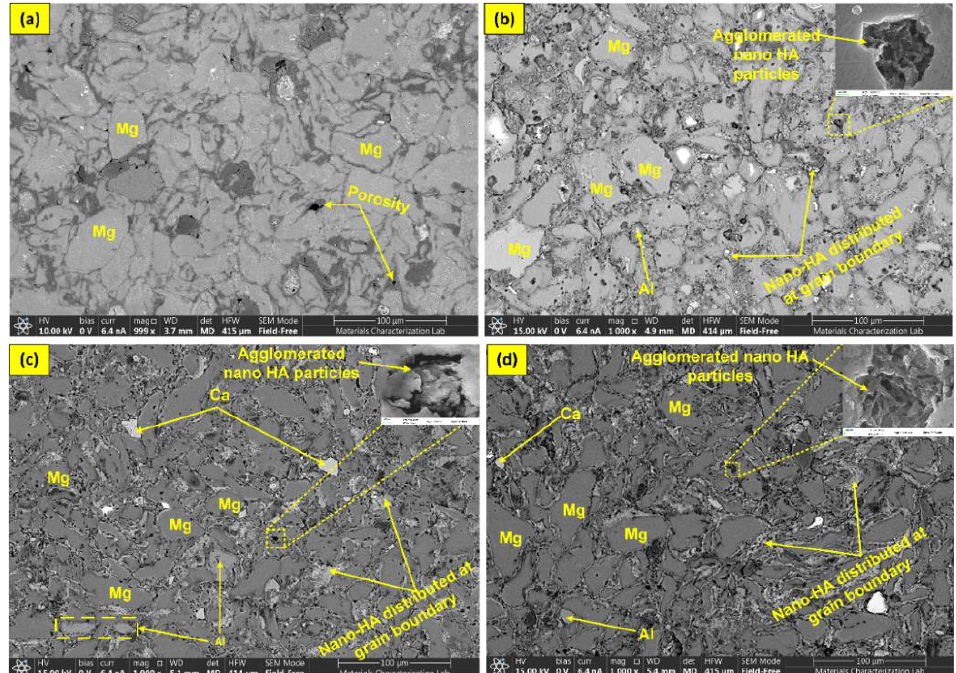
Figure 6. Backscattered electron microscopic SEM image of sintered BMMCs; ( a ) AZ31-0HA, ( b ) AZ31-10HA, ( c ) AZ31-15HA and ( d ) AZ31-20HA. Figure 7 represents the elemental mapping of microwave-sintered AZ31-HA compos- ites with the percentage of elements present in the EDX samples. These results confirm the Mg, O, Ca, P and Al distribution. Zn is present in a very small weight percentage, less than the detectable limit in elemental mapping, while it is found in the elemental percentage data. EDX results depict Mg as green in color and uniformly distributed. It also has proper grain size. Conversely, Ca, P and O are available as HA at the grain boundaries of magnesium due to the nano size of HA particles. Al and Ca are observed as free